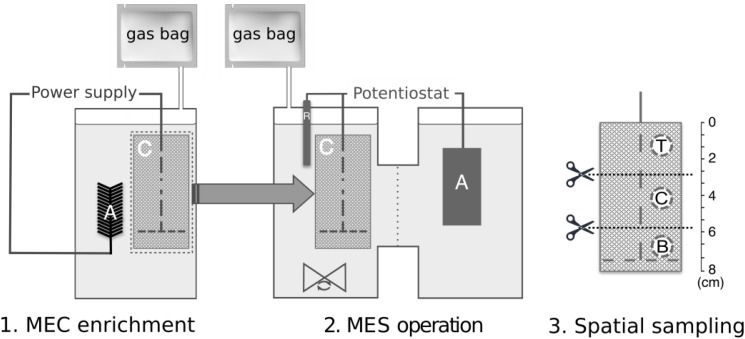
Experimental set-up and workflow, indicating (1) MEC enrichment phase followed by transfer of biocathode to (2) dual-chambered MES reactors, and (3) spatial sampling along the biocathode of MES at positions T, top; C, center; and B, bottom, for subsequent protein and DNA extraction and analysis. “A,” “C,” and “R” within the reactor schematic refer to anode, cathode, and reference electrode, respectively.